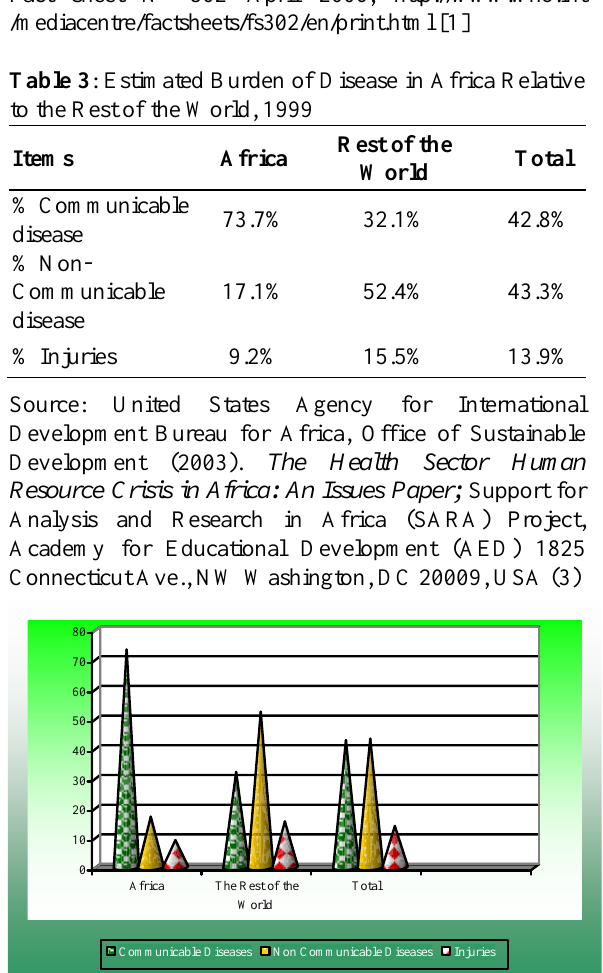
Figure 2: Percentage burden of disease in Africa and in the rest of the world, 1999.